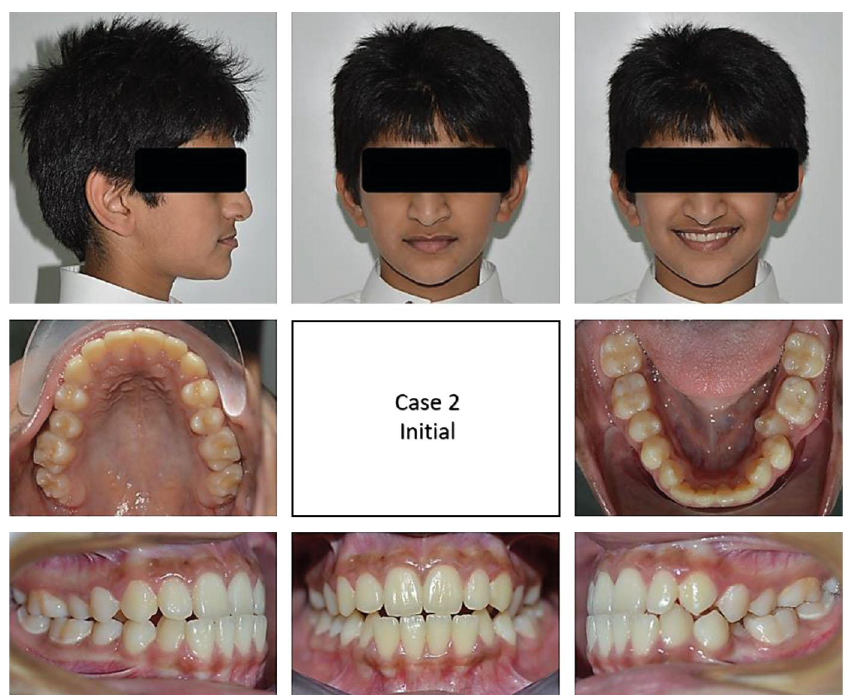
Figure 8: Pretreatment extraoral and intraoral photographs of the